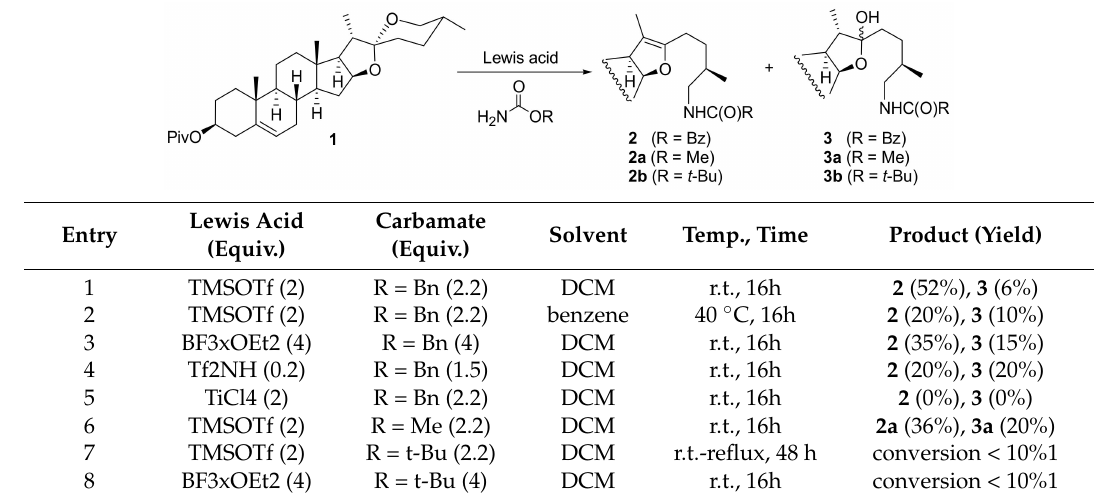
Table 1. Study of diosgenin pivalate reactions with carbamates in presence of Lewis